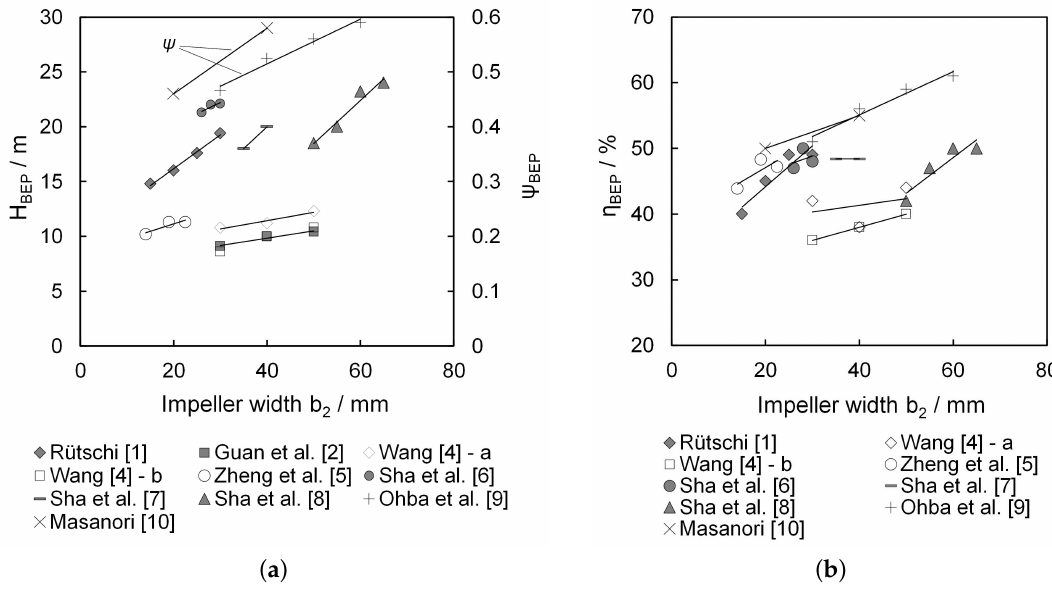
Figure 9. ( a ) Head and pressure coefficient over impeller width; and ( b ) efficiency over impeller